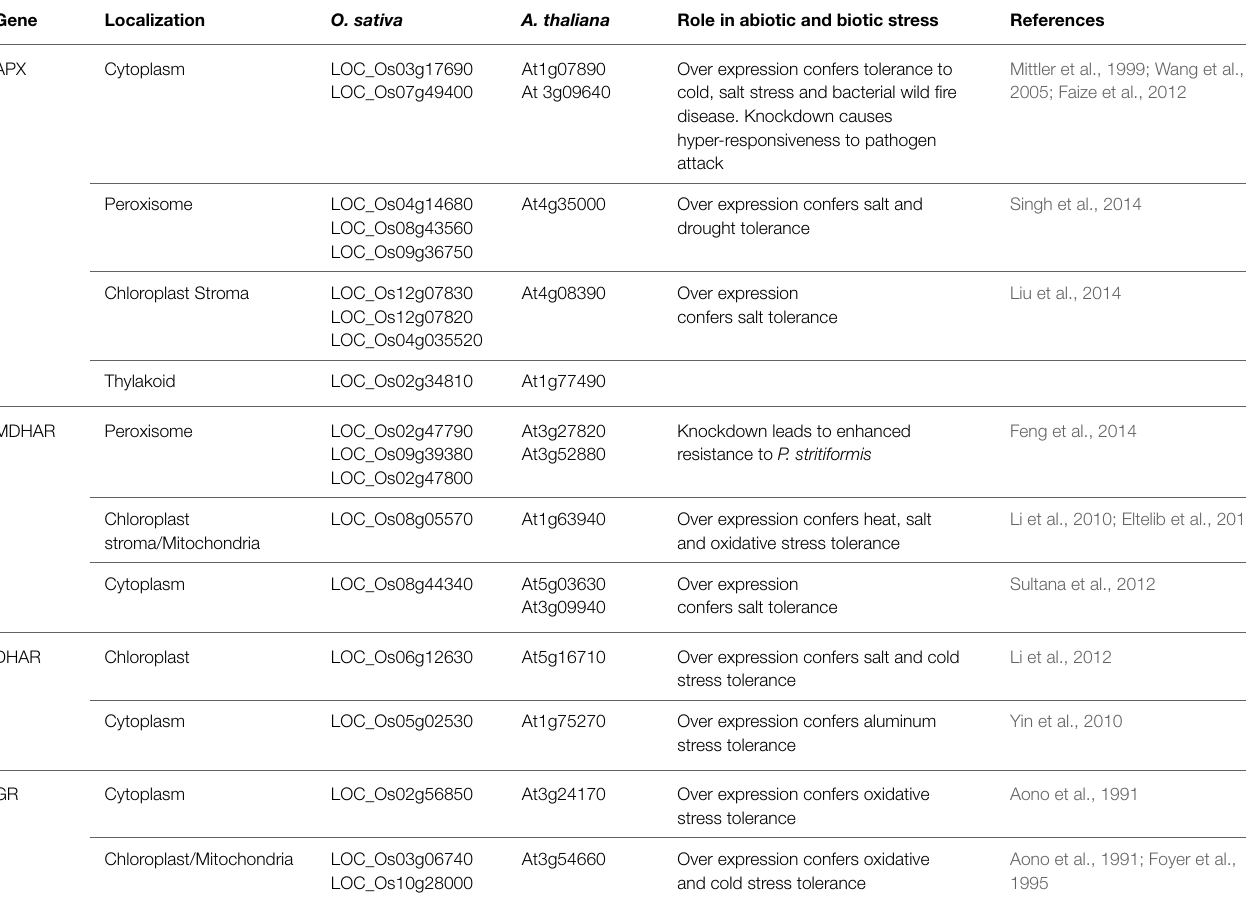
TABLE 2 | AsA-GSH pathway gene families in A. thaliana and O.sativa and their role in abiotic and biotic stress tolerance.